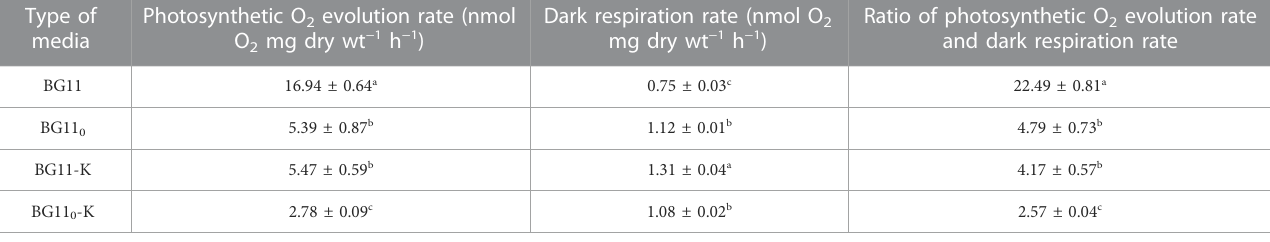
TABLE 2 Photosynthetic O 2 evolution rate, dark respiration rate, and ratio of photosynthetic O 2 evolution rate and respiratory rate in A. halophytica cells incubated in BG11, BG110, BG11-K, and BG110-K under dark anaerobic condition for 24 h before measuring. Data are means ± SD ( n = 3). Different letters in columns indicate a signi fi cant difference, and the same letter indicates no signi fi cant difference according to Duncan ’ s multiple range test at p < 0.05. Type of media